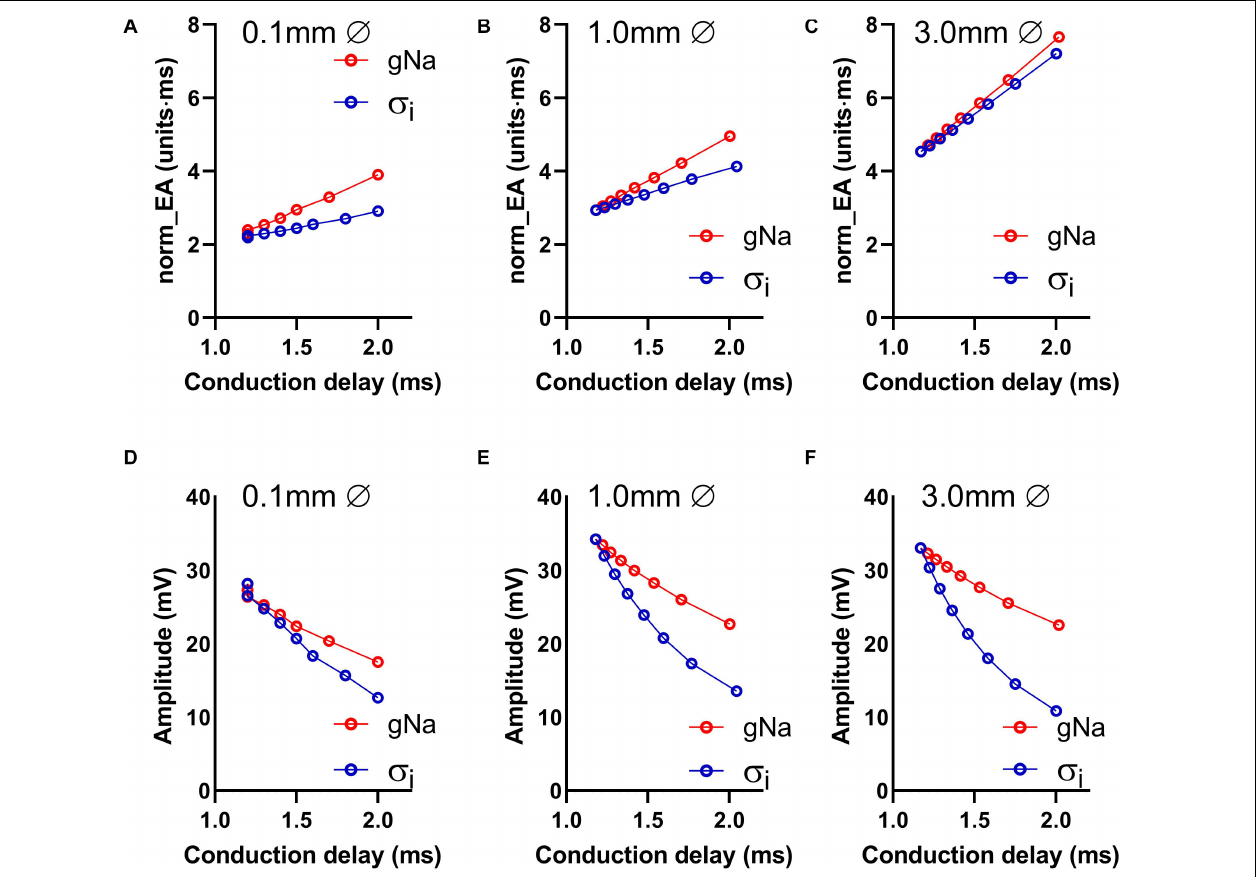
FIGURE 4 | Influence of altered sodium channel conductance and intracellular conductivity on electrogram morphology and its relationship with local conduction delay. (A–C) Data showing the impact of altering electrode diameter on the relationship between normalized electrogram area (norm_EA) and local tissue conduction delay with altered sodium channel conductance (gNa)/intracellular conductivity ( σ i ) in a computational model of a propagating mouse ventricular action potential. Data are shown for three different electrode diameters. (D–F) The same data for bipolar electrogram